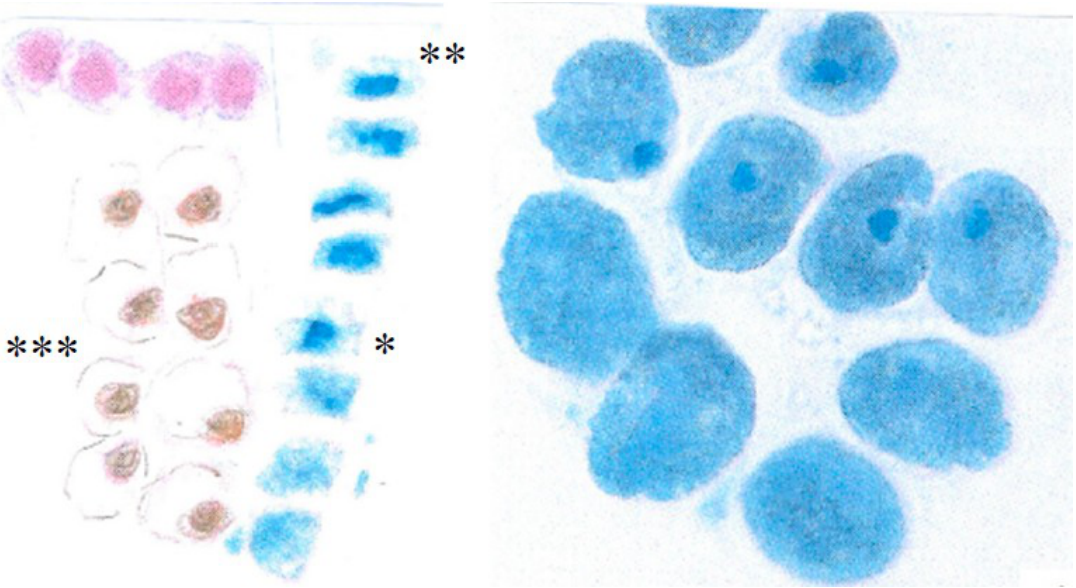
Figure 1. Eight brown burned lineage nuclei and 4 healthy nuclei stained with propidium iodide for DNA ( a ) and expanding lineage cells ( b ) from T. baccata, blue colors are DMACA